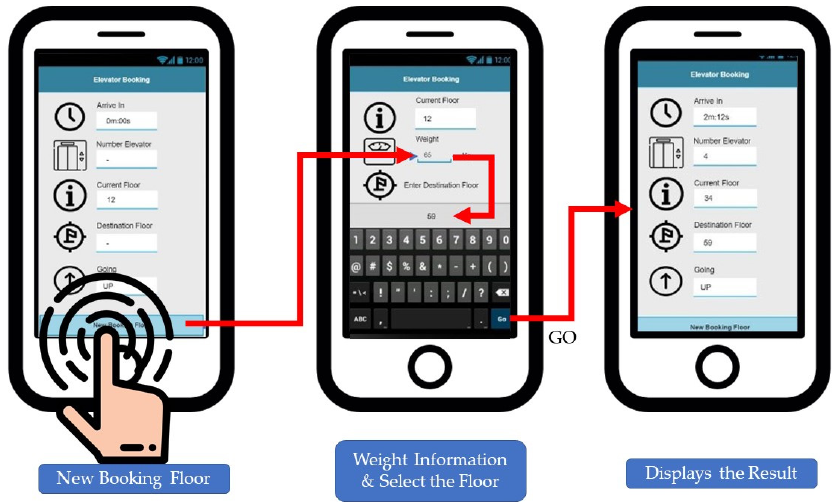
Figure 2. The proposed user interface.